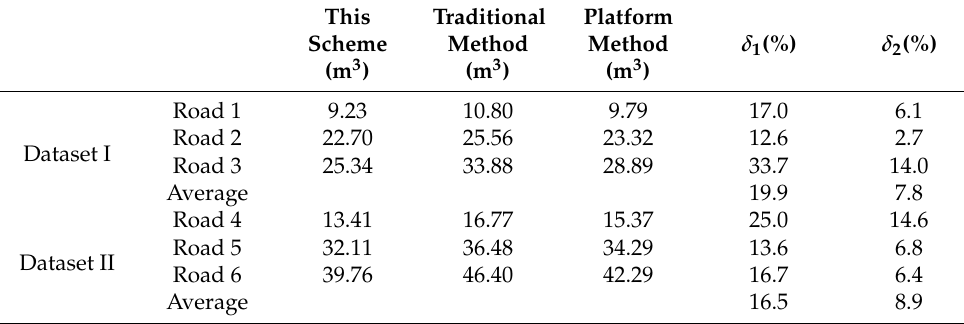
Table 3. Comparison of LVV calculation